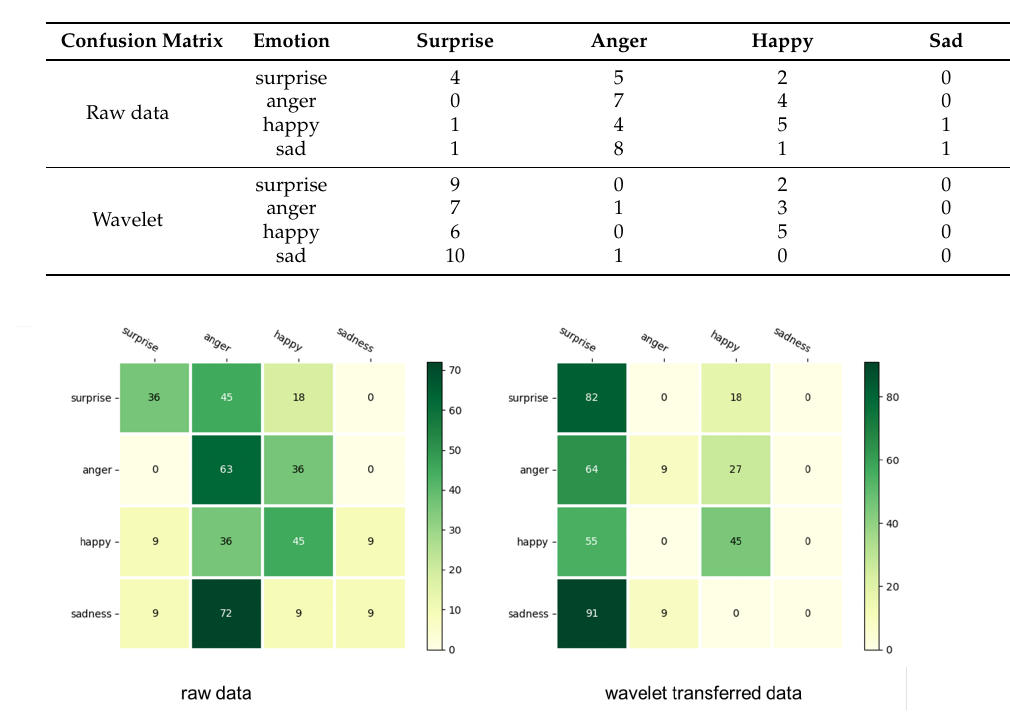
Figure 6. ( Left ) recognition rate for each emotion in raw data; ( right ) recognition rate for each emotion in wavelet-transferred